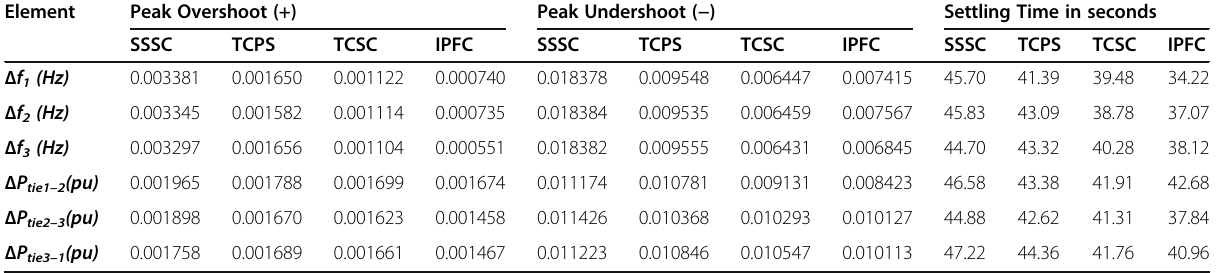
Table 4 Peak deviation and settling time for effectiveness measurement of FACTS devices Element